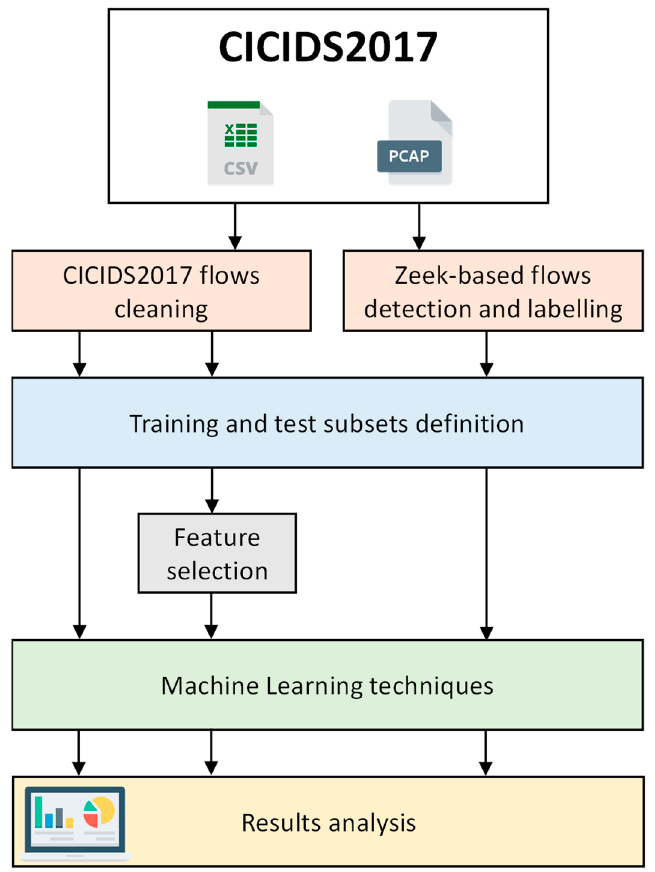
Figure 1 . General methodology